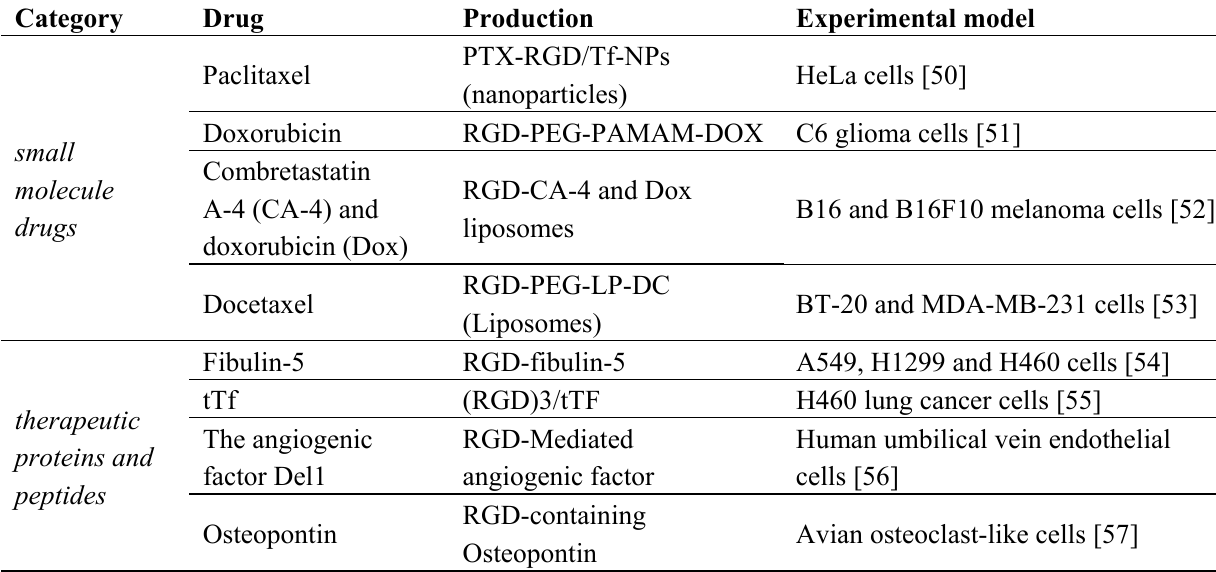
Table 3. RGD modified